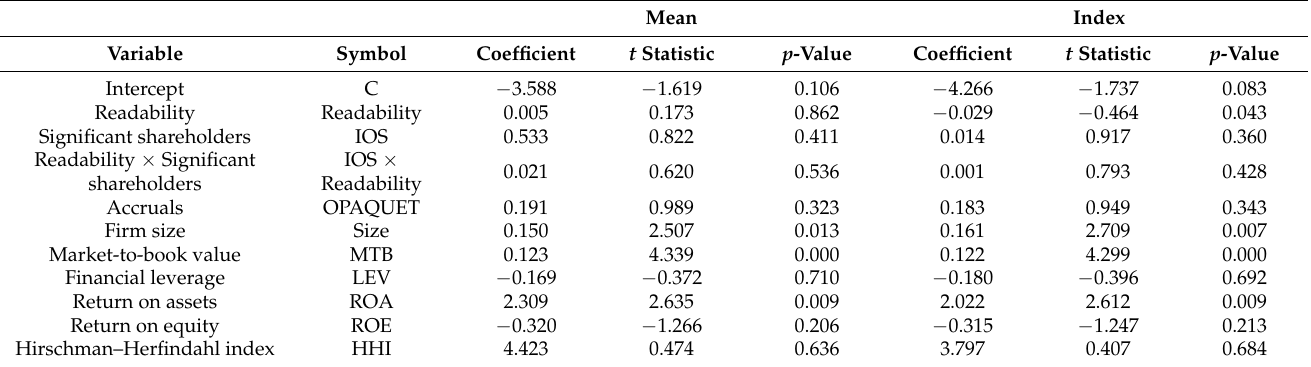
Table 9. The result of the third model by changing the index related to the significant